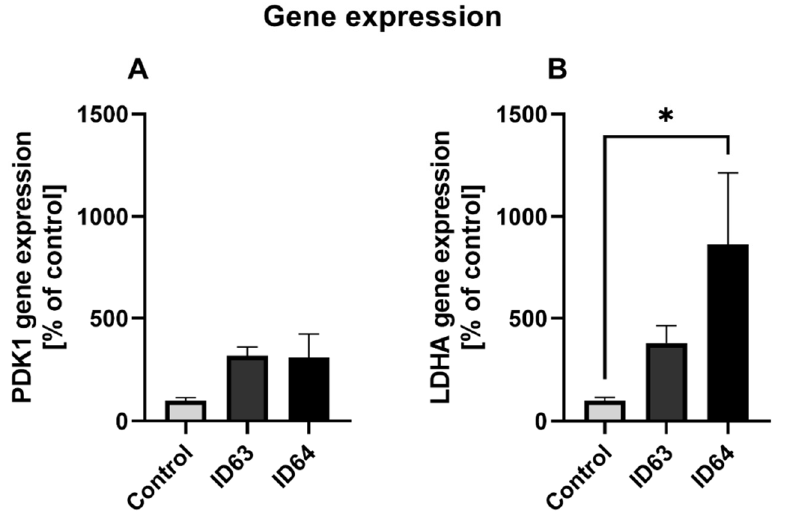
Figure 6. Effect of the incubation with ID63 or ID64 on the gene expression after 24 h of incubation. ( A ) Gene expression of pyruvate dehydrogenase kinase 1 (PDK1) of SH-SY5Y 695 cells after the incubation with ID63 or ID64 compared to the control. ( B ) Gene expression of lactate dehydrogenase A (LDHA) of SH-SY5Y 695 cells after the incubation with ID63 or ID64 compared to the control. N = 8. Significance was determined by one-way ANOVA. * p < 0.05. Data are displayed as the mean ± SEM. ID63 = 200 µM MgOr and 10 µM Fol; ID64 = 200 µM MgOr, 10 µM Fol and 100 nM Vit B6.